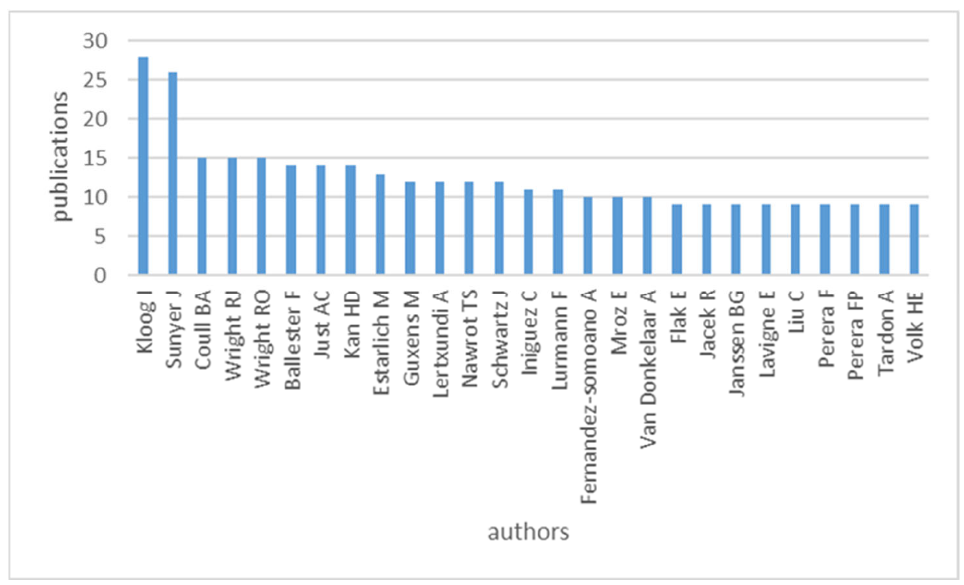
Figure 4. The most productive authors in the prenatal exposure to air pollution literature.